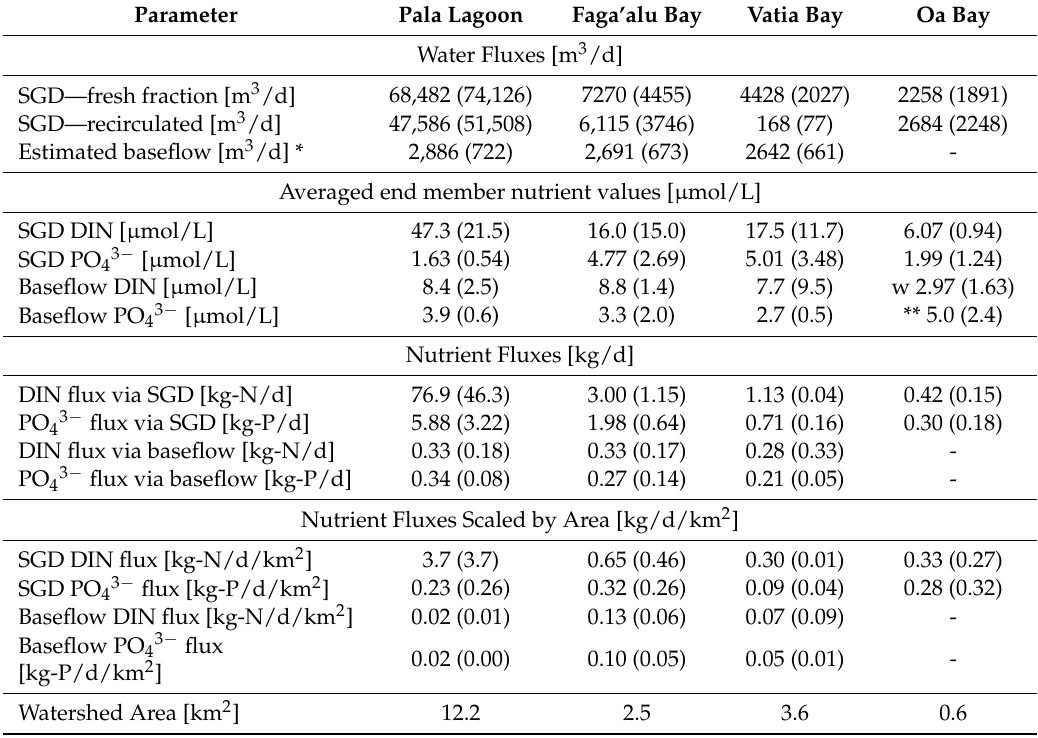
Table 4. Measured and estimated volumetric SGD and baseflow discharges, end member nutrient concentrations, and calculated nutrient loads, both absolute and area scaled. Values in parentheses are 1 σ standard deviations for end member values or are propagated uncertainties for calculated